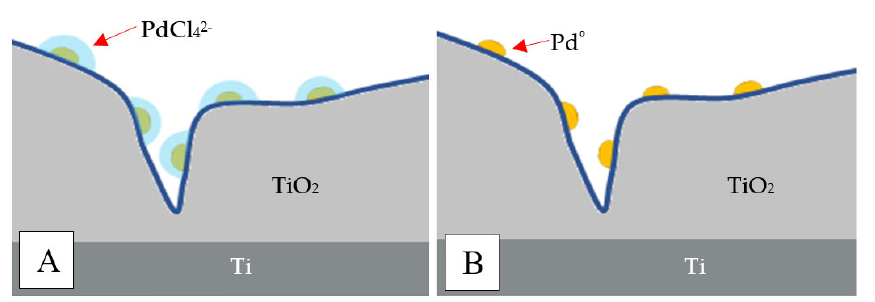
Figure 5. Effect of H 2 reduction on Pd active sites: ( A ) before reduction; ( B ) after reduction.